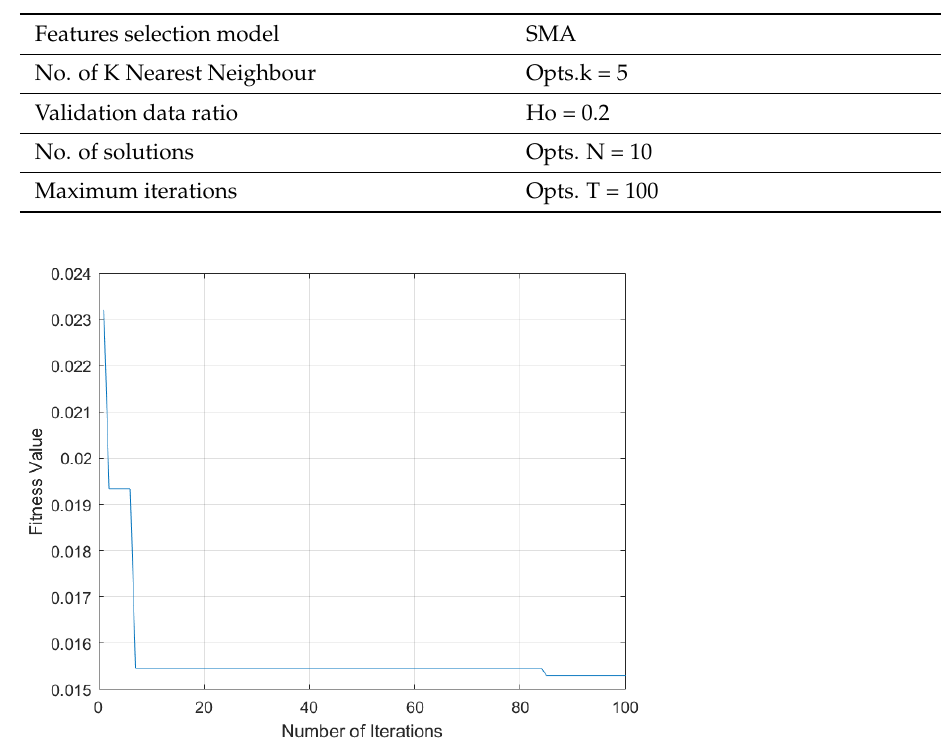
Table 2. Selected parameters of SMA.